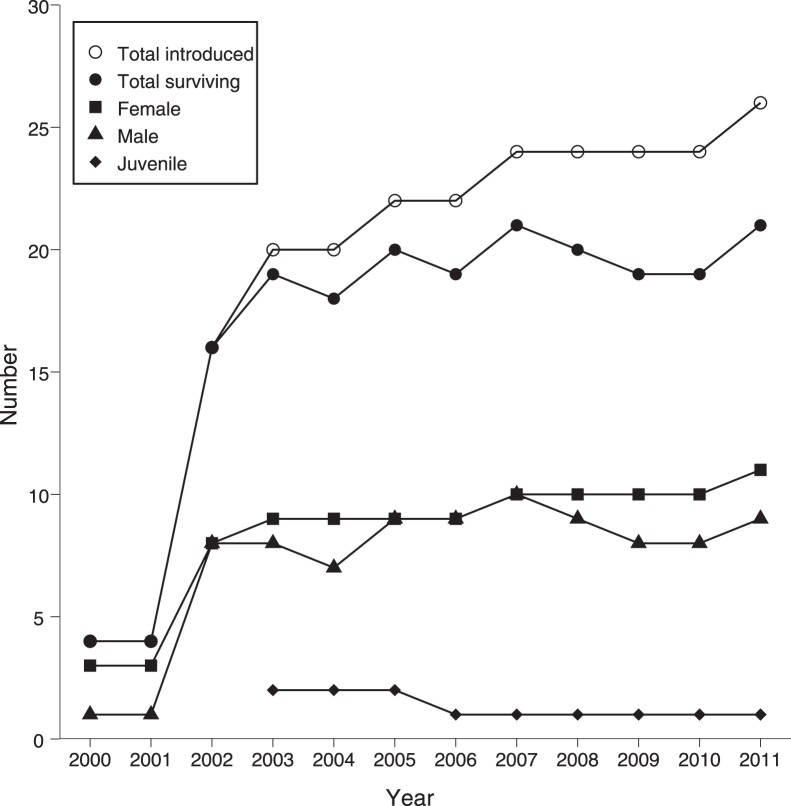
Total number of Aldabrachelys gigantea introduced in 2000 and surviving on Ile aux Aigrettes in 2011.
Table S1 shows which animals were juvenile, subadult or adult when first introduced. While male and female adult and subadult tortoises are presented separately, the subadults were not sexually mature. Juveniles were those animals which were not sexually mature and whose sex could not be determined.